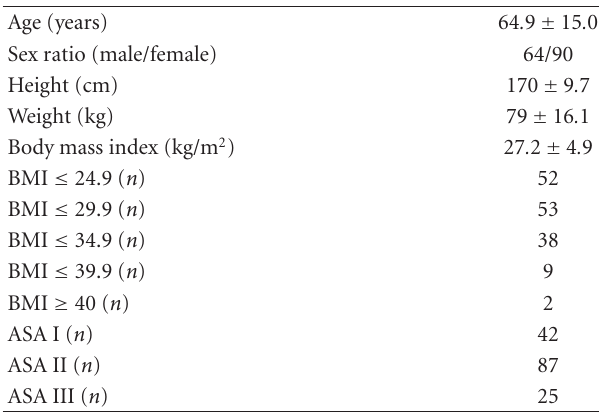
Table 1: Demographic